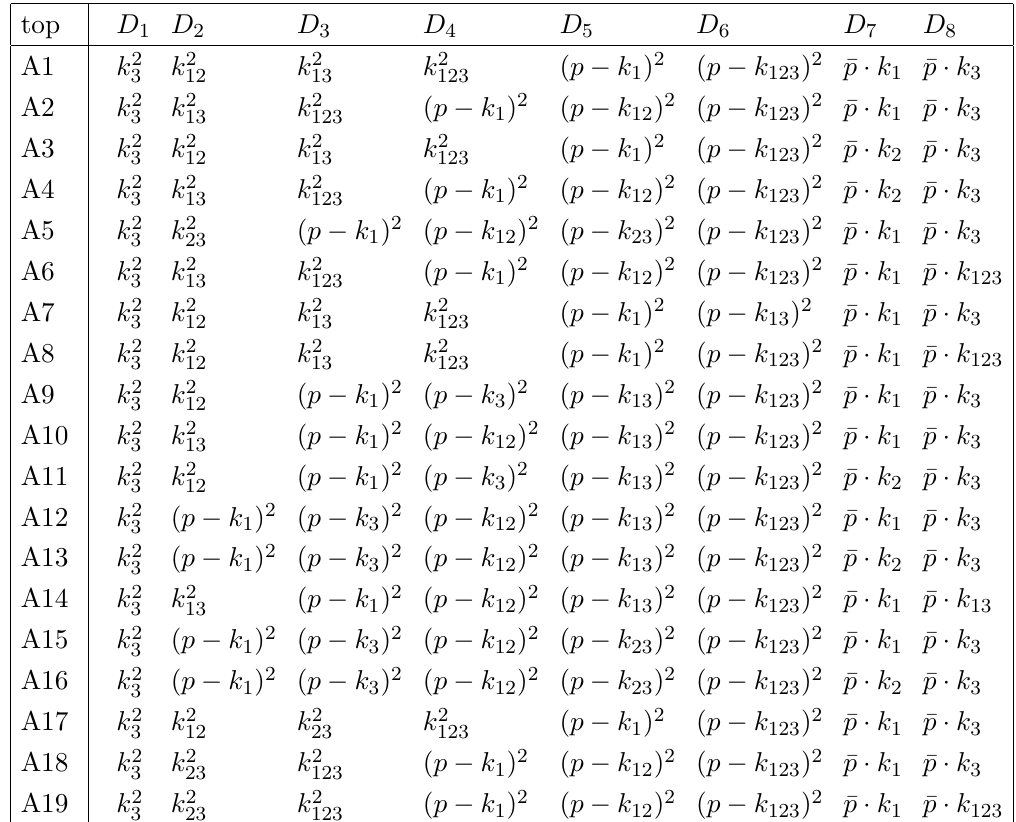
Table 1 . The inverse propagators D i for each of the 19 topologies A1, : : : , A19. Here we use